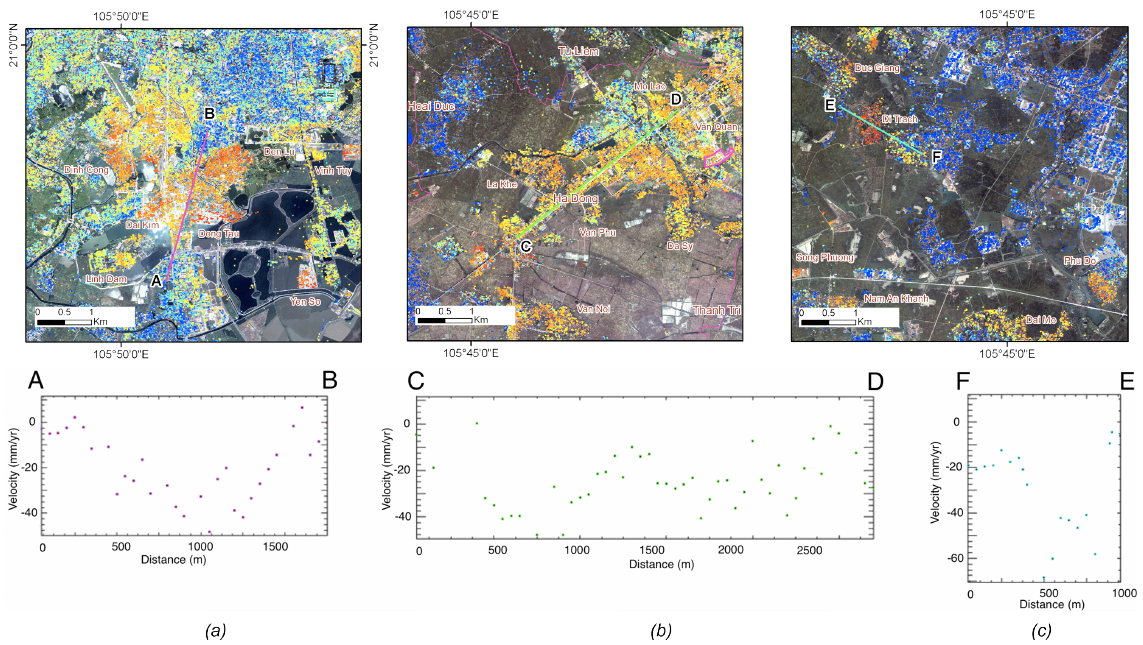
Fig. 4. Close-up maps and vertical velocity profile of (a) the Hoang Mai subsidence area, (b) the Ha Dong subsidence area (magenta boundary presents monitoring subsidence by leveling at Van Quan residential zone), and (c) the Hoai Duc subsidence area. For location of frame and color scale, refer to Fig.